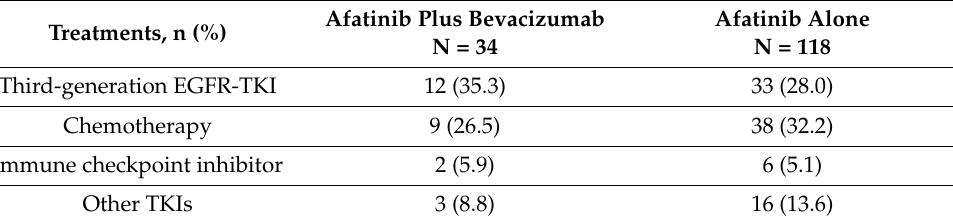
Figure 1. Survival outcome of ( A ) PFS and ( B ) OS between the afatinib plus bevacizumab and the single-agent afatinib groups in the propensity score-matched cohort. Table 4. Post-progression